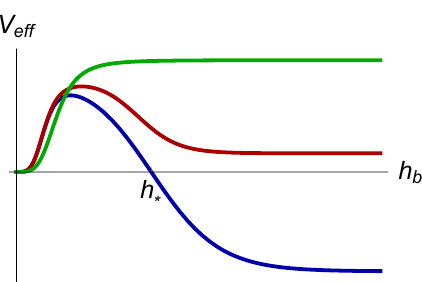
Figure 2. Possible forms of the e(cid:11)ective potential for the (cid:12)eld h b